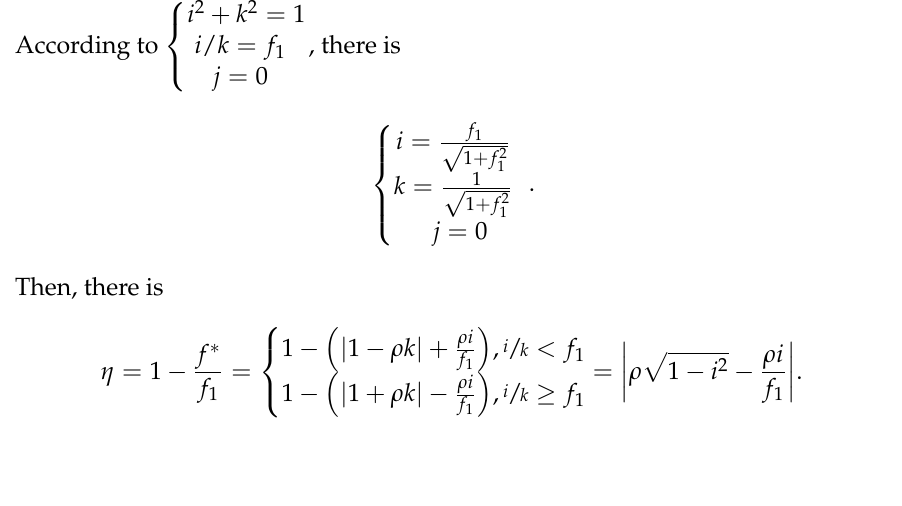
Figure 7. The negative gradient of the effective friction coefficient 𝜂 .